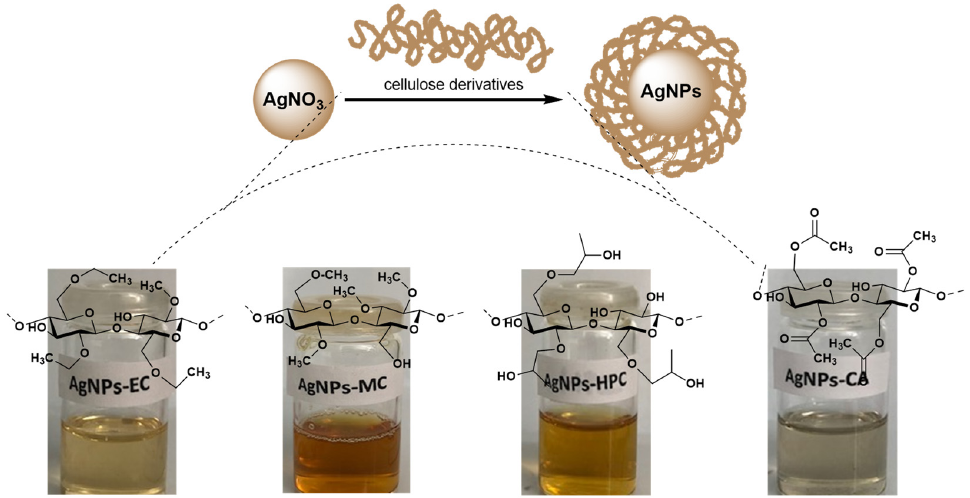
Figure 2 . An illustration of the silver nanoparticles formation mediated by cellulose derivatives (hy- droxypropyl cellulose (HPC), methylcellulose (MC), ethylcellulose (EC), and cellulose acetate (CA)).